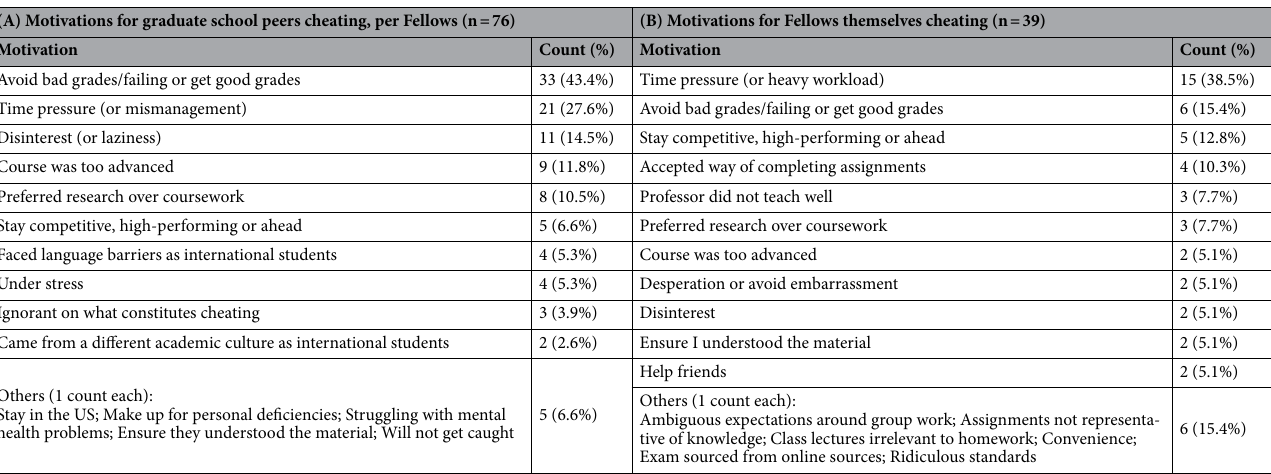
Table 4. Motivation for academic cheating in graduate school. NSF Fellows’ (A) perceived motivations for graduate peers cheating and (B) motivations for themselves cheating in college and graduate school. Ranked in decreasing order by